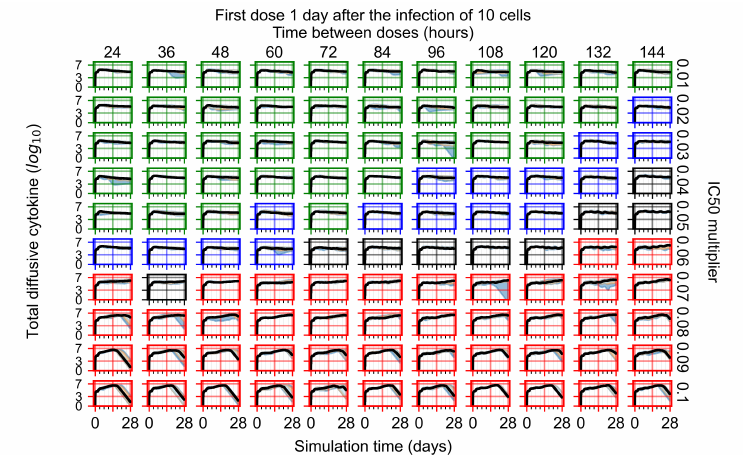
Figure A27. Diffusive cytokine amount, Y axis in log scale, and exponent values as tick marks.